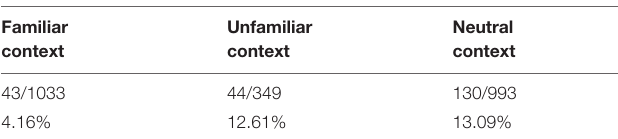
Table 8 | Proportion of interactions initiated by player 2. The player 2 violate the rule without any bribery from player